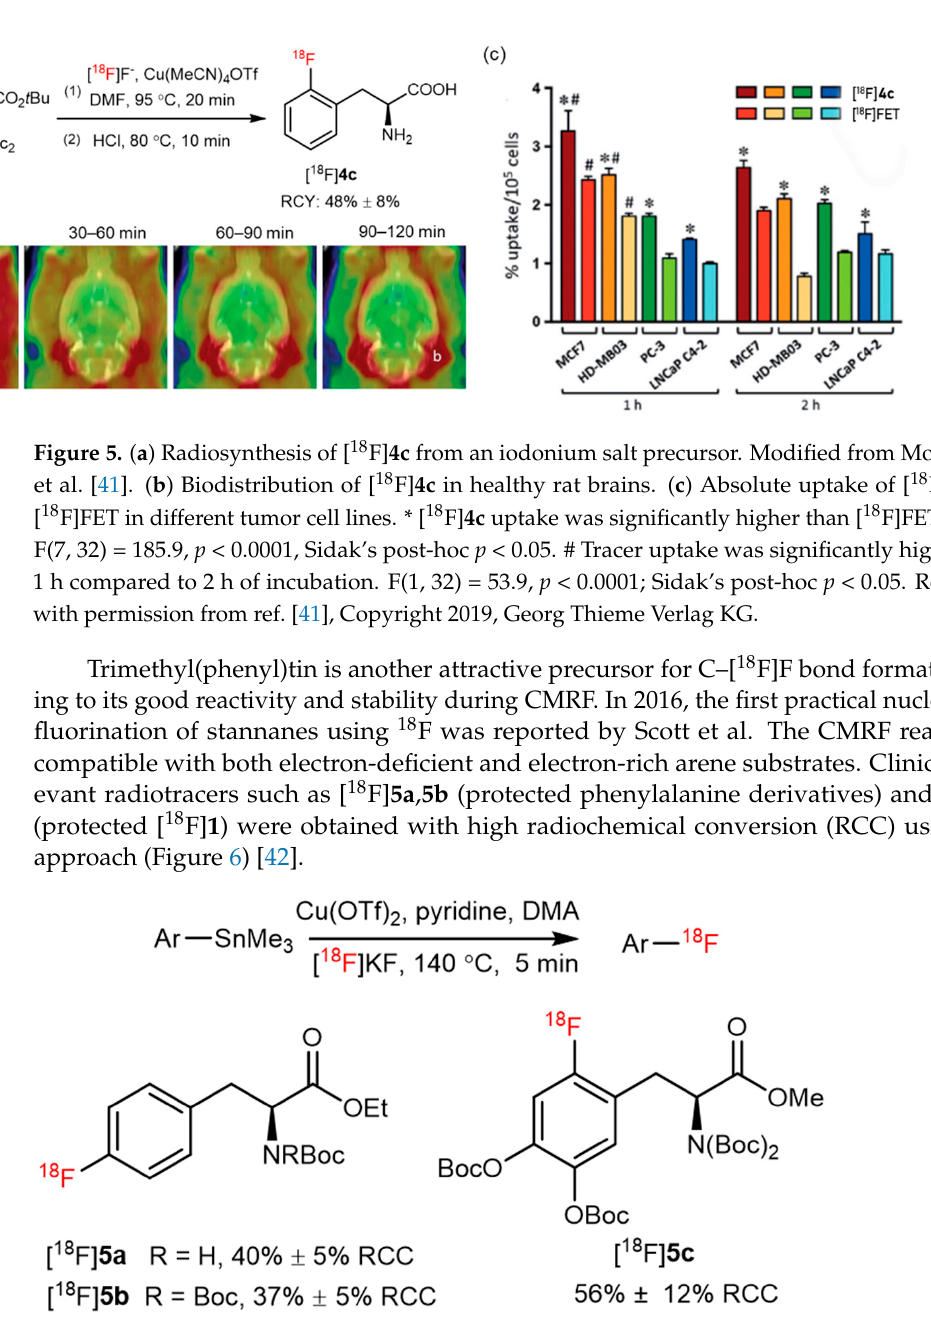
Figure 6. Radiosynthesis of [ 18 F] 5a , 5b and [ 18 F] 5c from trimethyl(phenyl)tin precursor. Modified from Makaravage et al. [42].